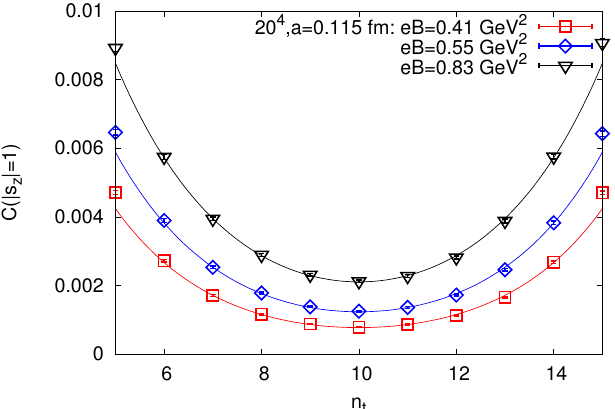
Figure 1. The correlation function of the (cid:26) + ( (cid:26) (cid:0) ) meson with the s z = +1 ( s z = (cid:0) 1) spin projection for m (cid:25) ( B = 0) = 535(4) MeV and several values of the magnetic (cid:12)eld. The curves are the (cid:12)ts of the lattice data made by the hyperbolic cosine function (2.19).